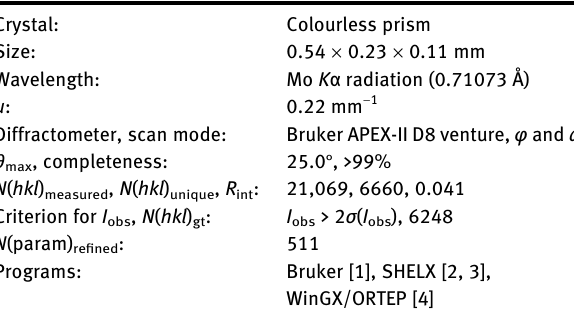
Table  : Data collection and handling.